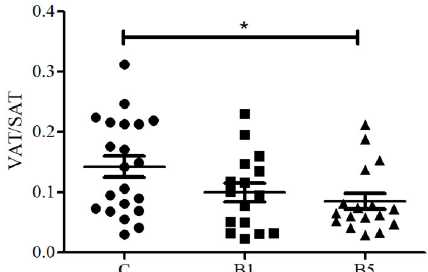
Figure 2. Visceral adipose tissue (mm 2 )/subcutaneous adipose tissue (mm 2 ) (VAT/SAT) ratio in the control group (C), and obese women evaluated one year (B1) and fi ve (B5) years after Roux- en-Y gastric bypass. Measurements were obtained by magnetic resonance imaging. Data are reported as means ± SD. *P o 0.05,